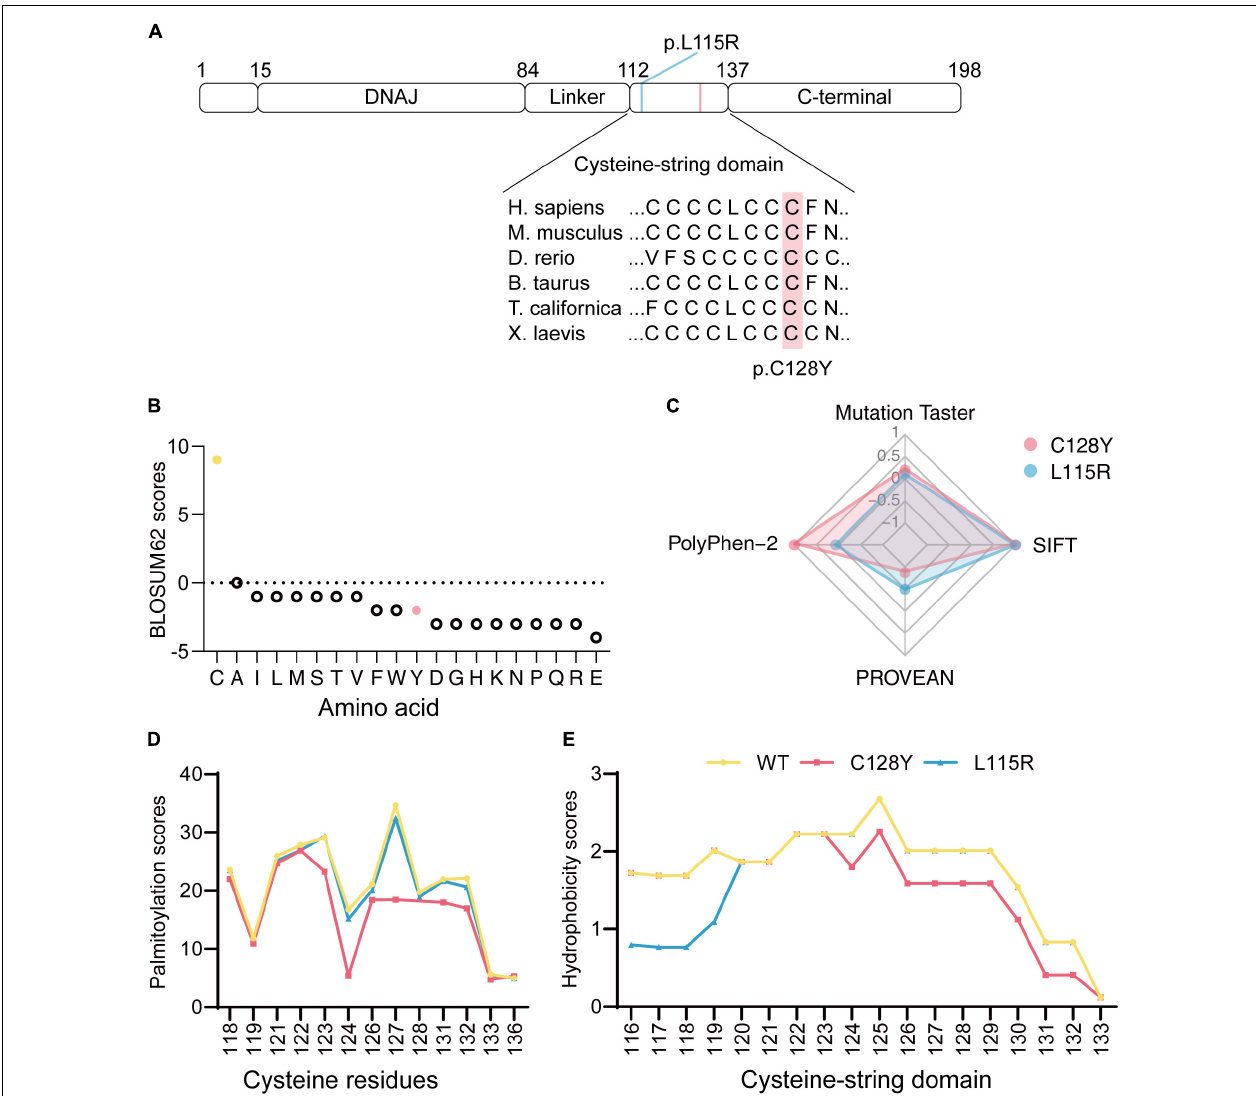
FIGURE 2 | In silico analysis of mutated DNAJC5 /CSP α . (A) Both p.L115R and p.C128Y are located at the cysteine-string domain, as visualized in the ideogram of CSP α . (B) The BLOSUM62 score indicated a rare substitution from cysteine to tyrosine at p.128. (C) Disease-causing potential, calculated with Mutation Taster, SIFT, PolyPhen-2, and PROVEAN, revealed worse pathogenicity for the C128Y mutation (1/100-fold change for scores from Mutation Taster, 1,000-fold change for scores from SIFT, 1/10-fold change for scores from PROVEAN). (D) The C128Y mutation decreased predicted palmitoylation score, indicating the potential difficulty of this mutant in forming disulfide bonds with palmitic acid. (E) C128Y mutation decreases the hydrophobicity of the cysteine-string